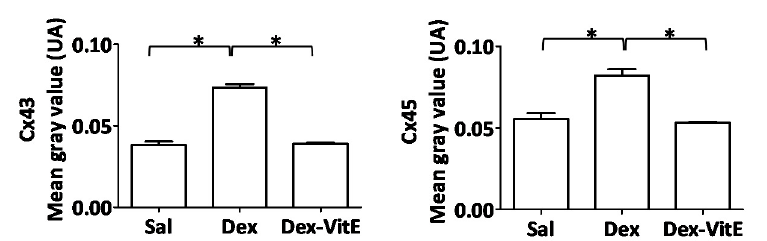
Figure 2. Vitamin E prevents the increase in connexin43 and Cx45 immunoreactivity induced by dexamethasone. The presence and cellular distribution of conneixn43 (Cx43, A ) and conneixn45 (Cx45, B ) was evaluated by immunofluorescence assays in slices of tibialis anterior muscle from mice treated with dexamethasone (Dex) or with saline solution or with Dex plus VitE rich diet (Dex + VitE). The graphs show the red fluorescence intensity for each connexin measured using Image J software. The results are expressed as mean ± SEM.* p < 0.05; comparing as indicated with brackets. Scale bar: 50 µ m. ( n = 3 individual animals per group).